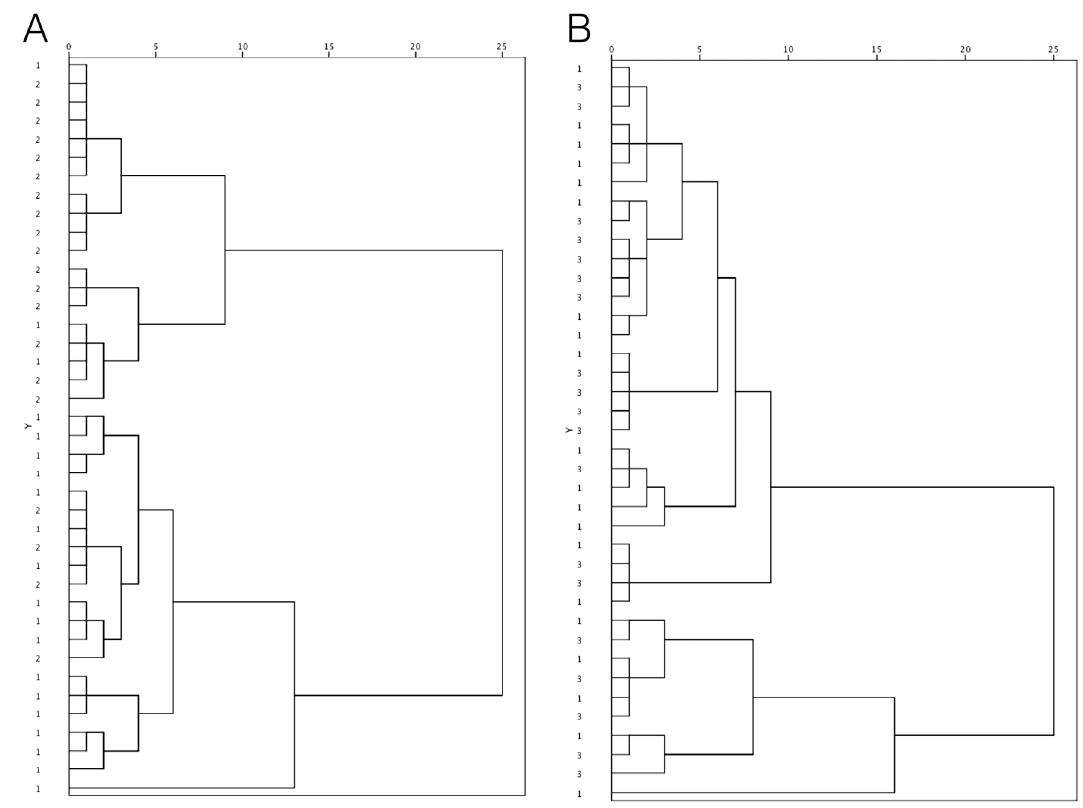
Figure 2. The dendogram obtained from saliva samples: ( A ) clustering of patients with untreated periodontitis (group 2) and healthy controls (group 1); ( B ) clustering of patients with treated periodontitis (group 3) and healthy controls (group 1).